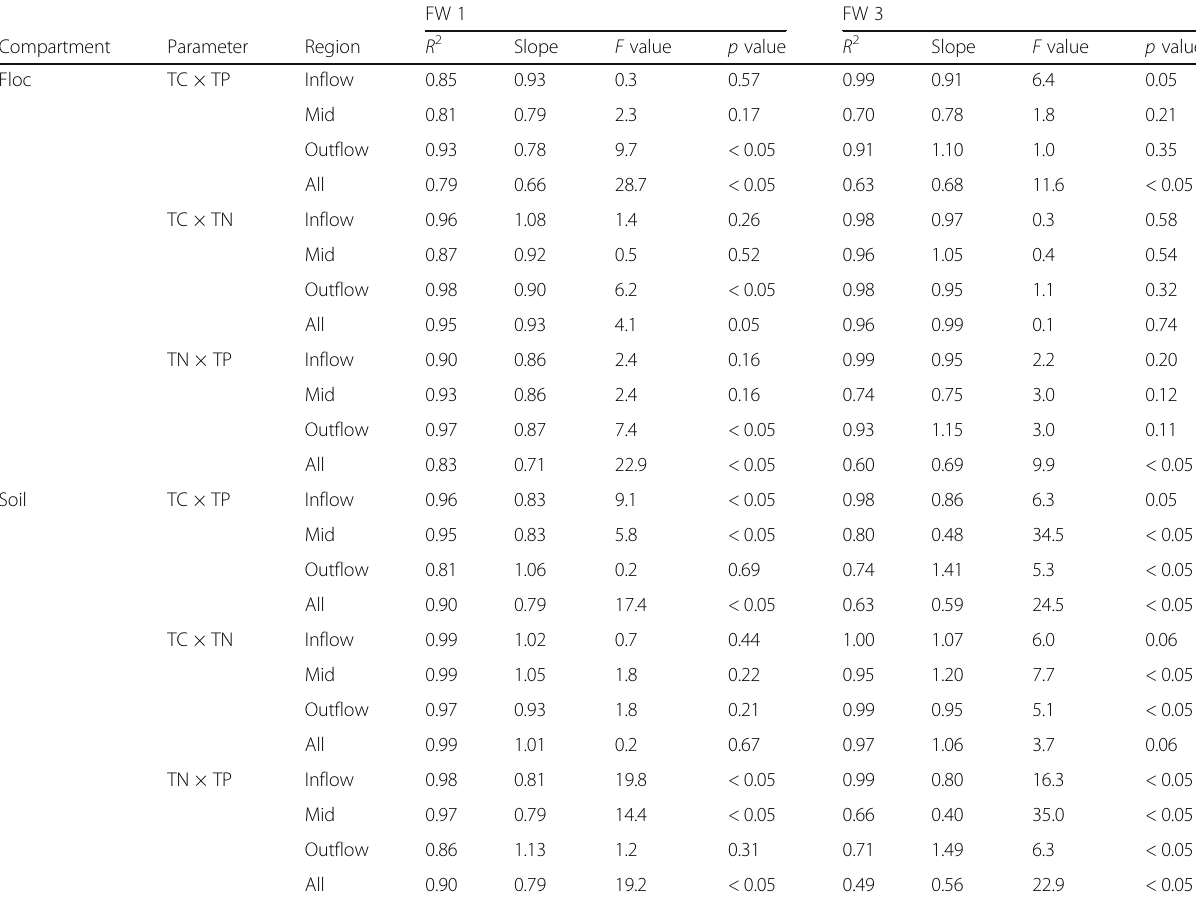
Table 3 Flocculent and soil standardized major axis regression results for flow way 1 (FW 1) and FW 3 within Stormwater Treatment Area-2 for inflow, mid, outflow, and entire FW (ALL) regions. Stoichiometric comparisons include total carbon to total phosphorus (TC:TP), total carbon to total nitrogen (TC:TN), and total nitrogen to total phosphorus